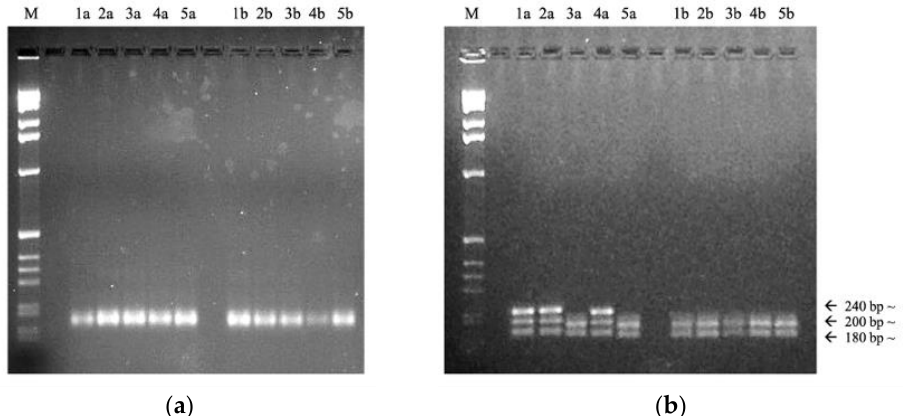
Figure 2. Fingerprint comparison. ( a ) Results obtained according to Chen et al. (2017) [22]. M: E-